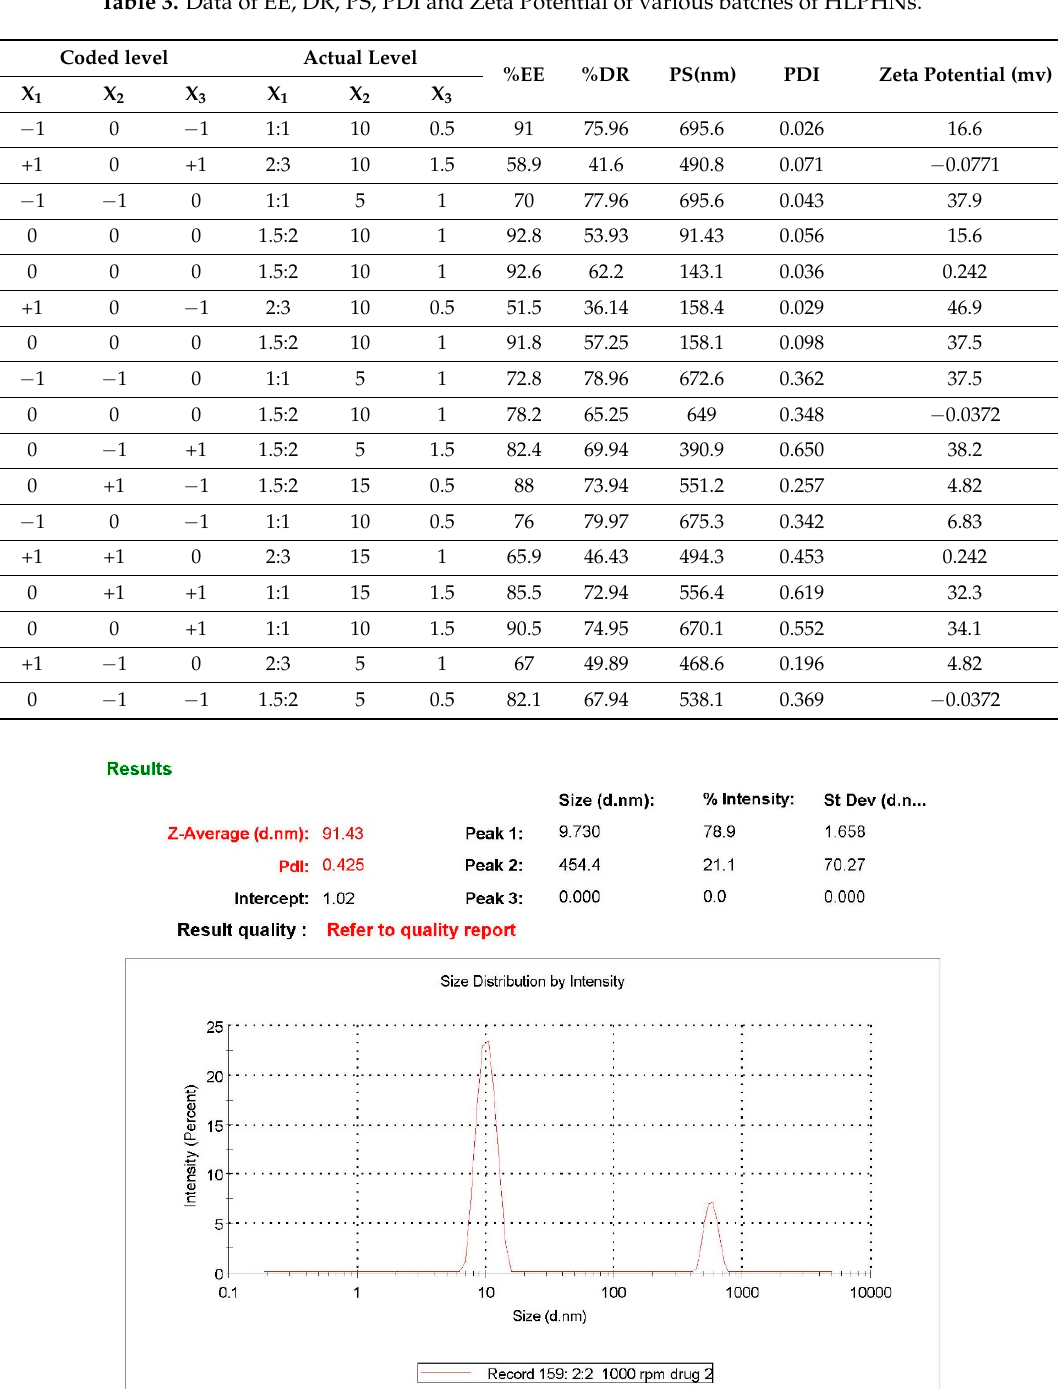
Table 3. Data of EE, DR, PS, PDI and Zeta Potential of various batches of HLPHNs.